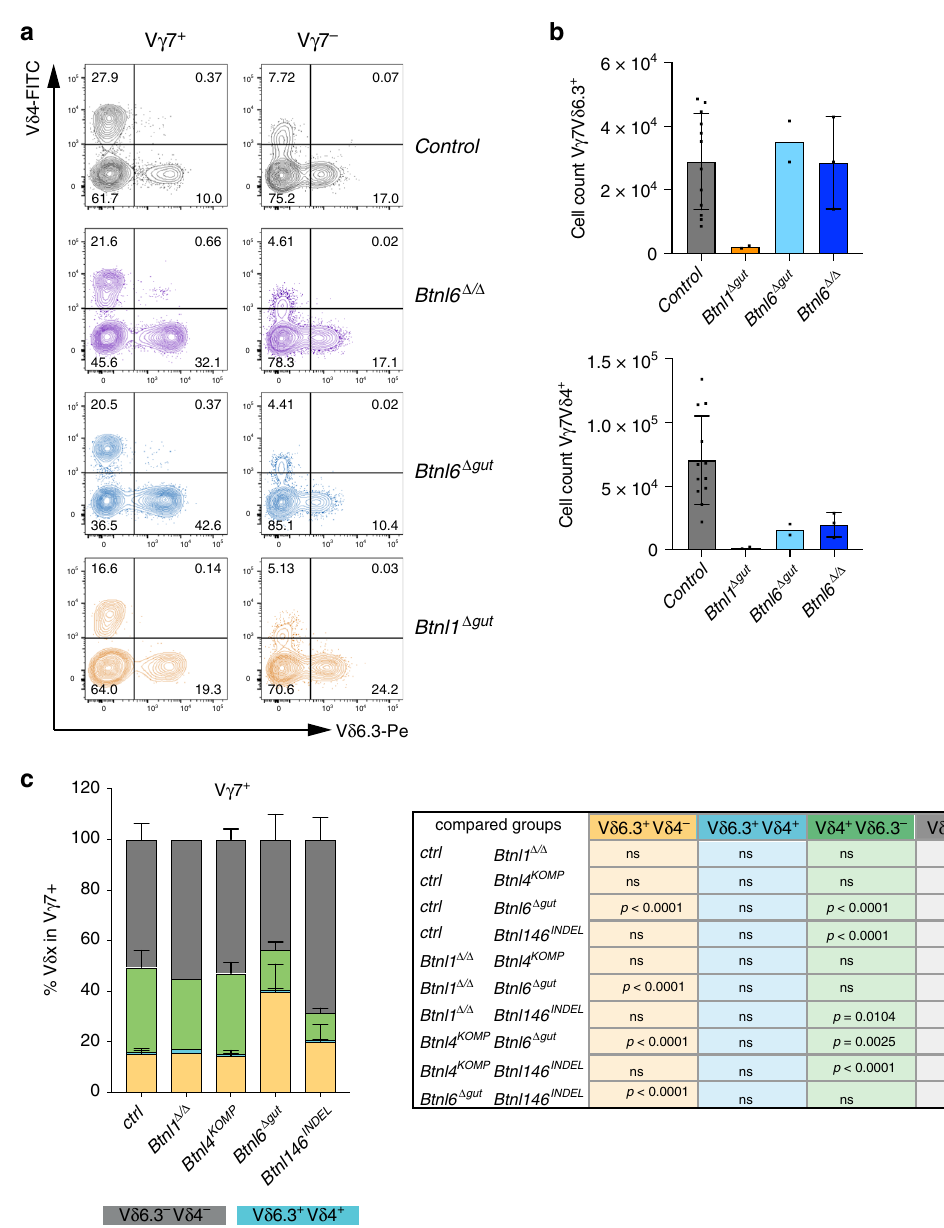
Fig. 3 Btnl6 de fi ciency alters V δ gene usage. a FACS plots of TCR δ chain usage in animals of indicated genotypes. The V δ 4 and V δ 6.3 chains are plotted against each other in V γ 7 + IEL (left column) and V γ 7 − cells (right column). b Quanti fi cation of V γ 7 + V δ 6.3 + (top) and V γ 7 + V δ 4 + cell numbers (bottom), in animals of indicated genotypes. n ctrl : 12, n Btnl1 : 2, n Btnl6 Δ gut : 2, n Btnl6 Δ / Δ : 3. Data are mean ± SD of a representative experiment. c Quanti fi cation of V δ - chain usage in V γ 7 + IEL as depicted in quadrants ( a ) in animals of indicated genotypes n ctrl : 7, n Btnl1 : 2, n Btnl4KOMP : 3, n Btnl6 Δ gut : 5, n Btnl146Indel : 4. Statistical analysis: two-way ANOVA & Tukey ’ s multiple comparison post test. Data are mean ± SD of a representative